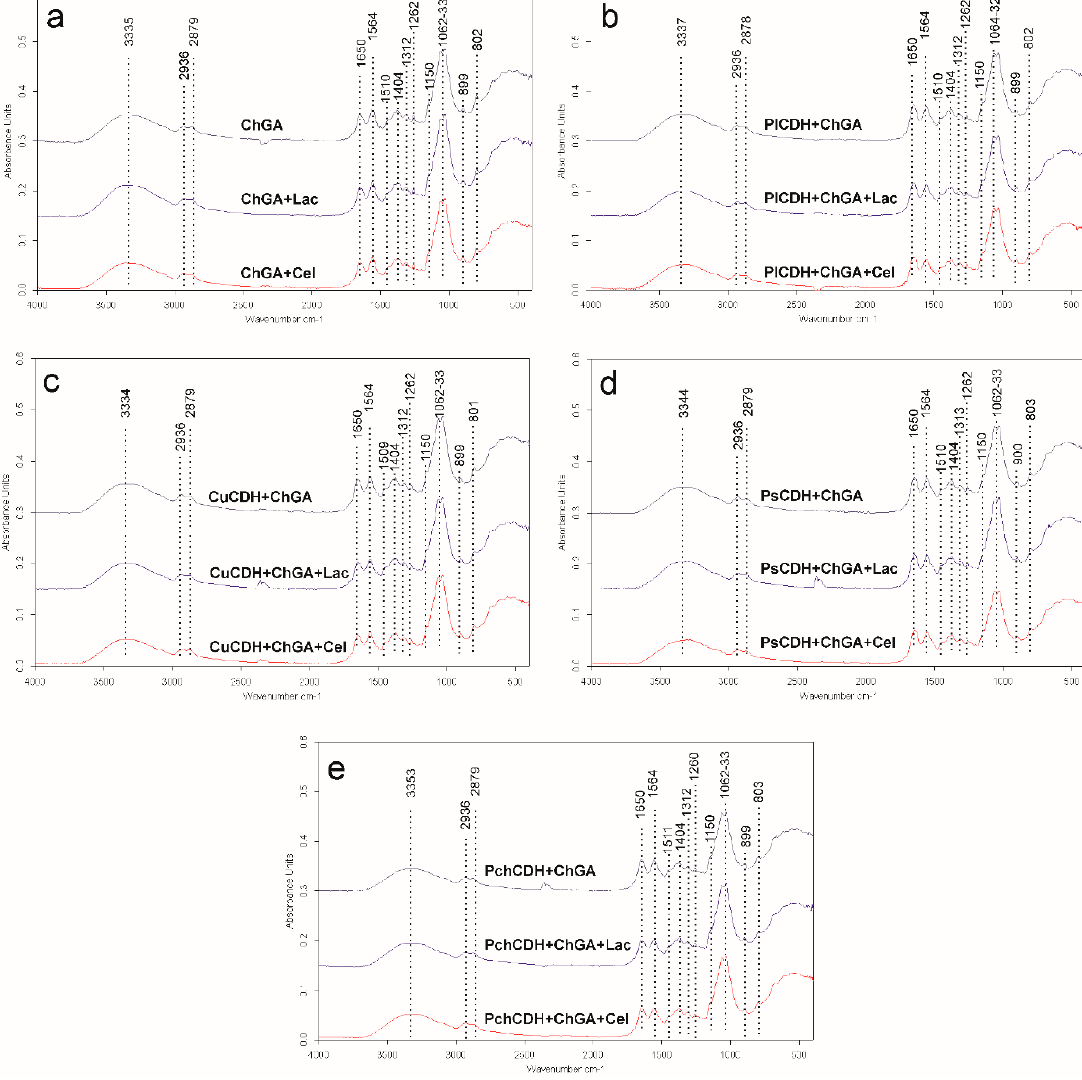
Figure 2. ( a ) FTIR spectra of chitosan with glutaraldehyde (ChGA) (C1-control), ChGA + Lac (C2-control), ChGA + Cel, (C3-control); ( b ) FTIR spectra chitosan with glutaraldehyde (ChGA) contain-